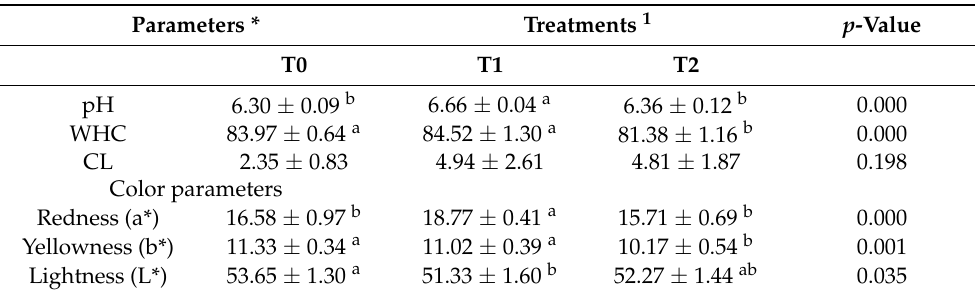
Table 4. Physicochemical parameters of